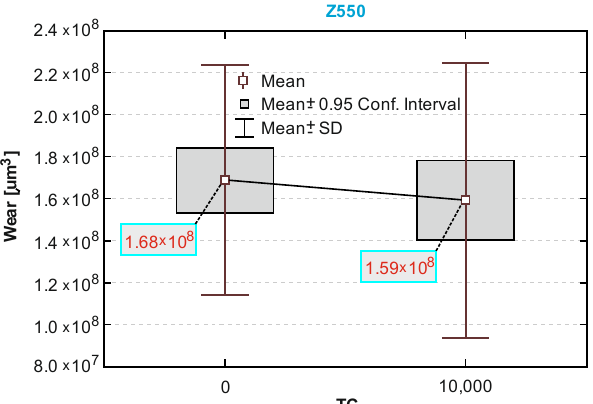
Figure 10. A box-and-whiskers plot of the wear resistance of the composite Z550.